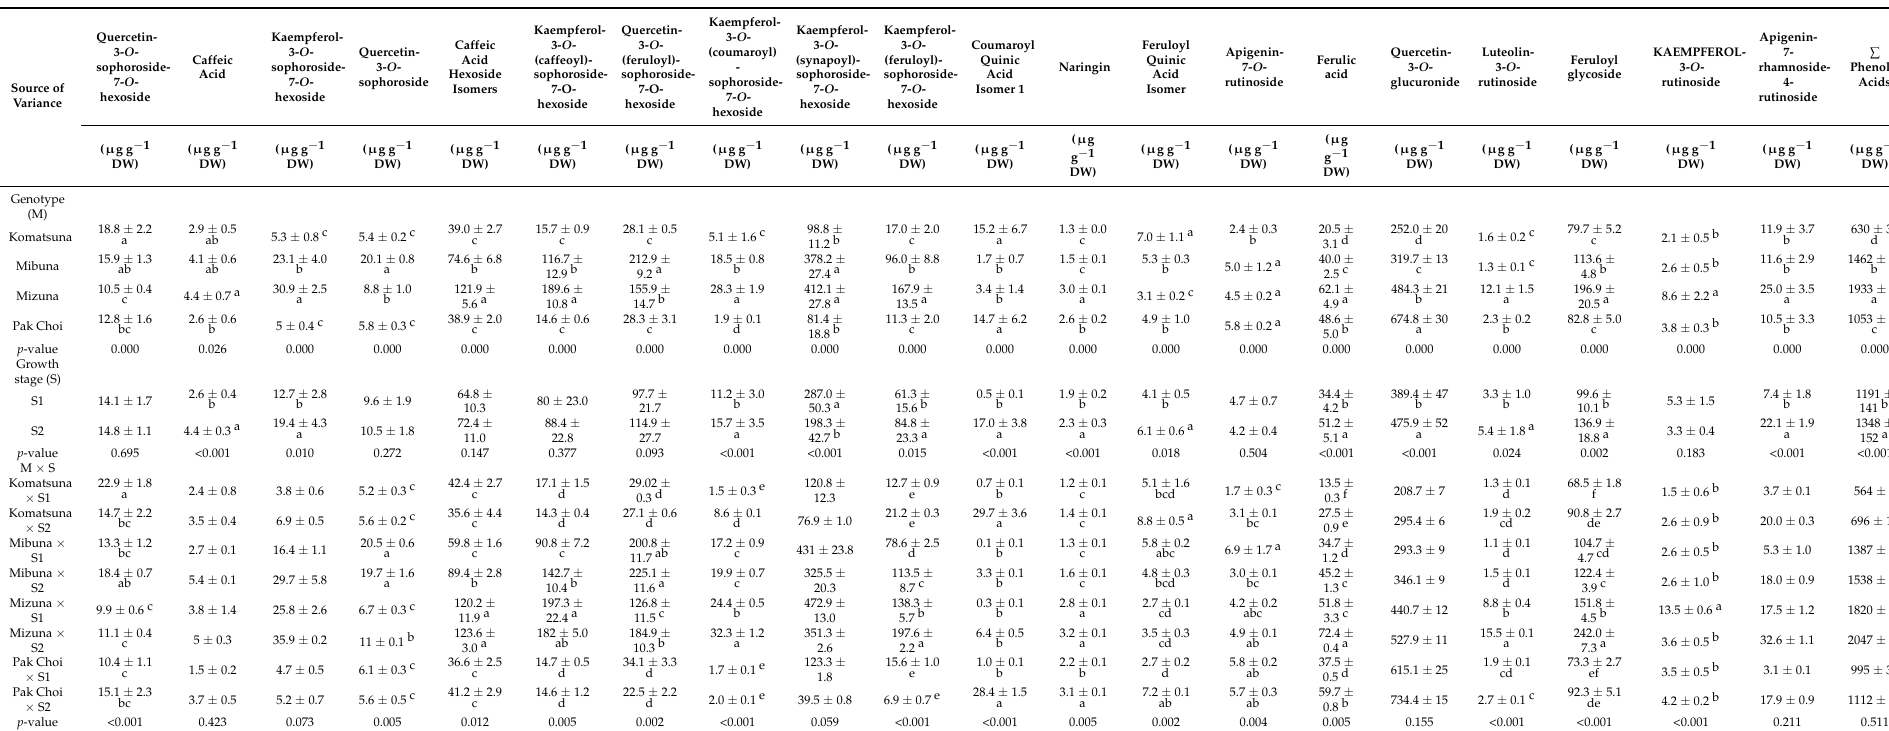
Table 6. Phenolic composition of four Brassica rapa L. microgreens harvested at the first (S1) or second true-leaf stage (S2). All data are expressed as mean ± standard error, n = 3.